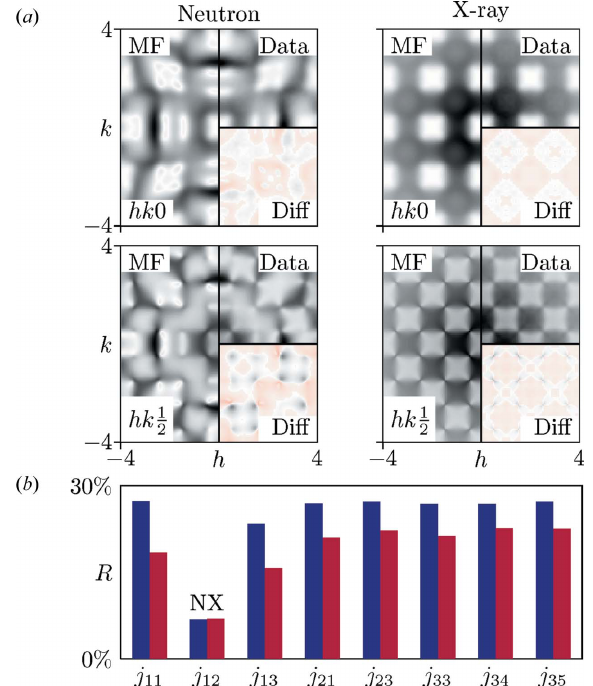
Figure 6 ( a ) Slices of the 3D diffuse neutron and X-ray scattering calculated from our MF refinement (left) compared with the calculated data (top right). The lower right-hand corner shows the difference I MF (cid:6) I exp , where positive (negative) values are displayed on a white to black (red) colour scale. ( b ) The variation in R values for the model-agnostic MF refinement of the 3D data with the different j xy . See the supporting information for further details of the nomenclature and the complete pair-interaction Hamiltonian. Neutron scattering (N) values are shown in blue and X-ray scattering (X) in refinements and the corresponding fits to the data are given as supporting information.